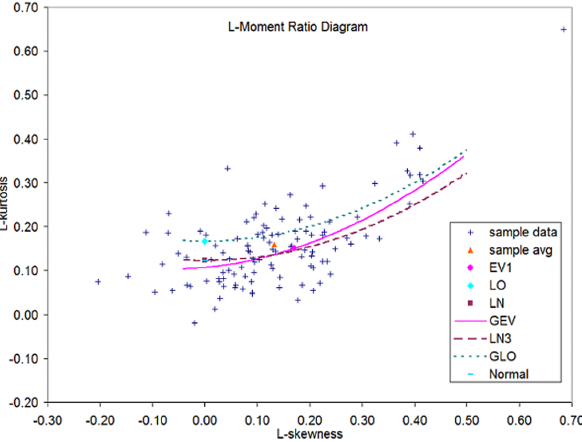
Fig. 10. L-moment ratio diagram for annual maximum flow for 110 Irish